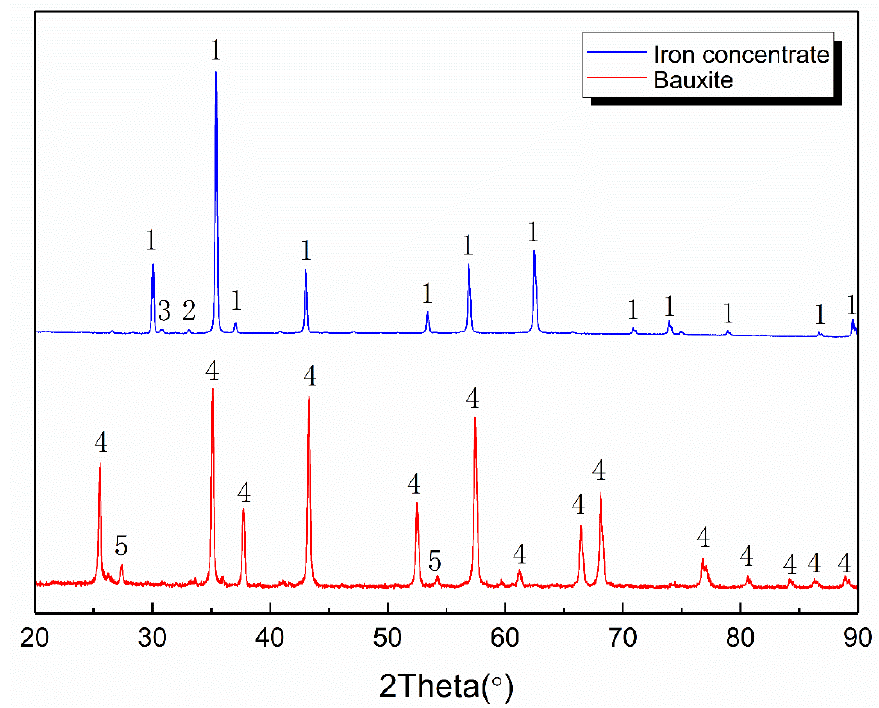
Figure 1. X-ray diffraction patterns of iron concentrate and bauxite (1-Fe 3 O 4 , 2-Fe 2 O 3 , 3-Diopside, 4-Al 2 O 3 , 5-TiO 2 ).